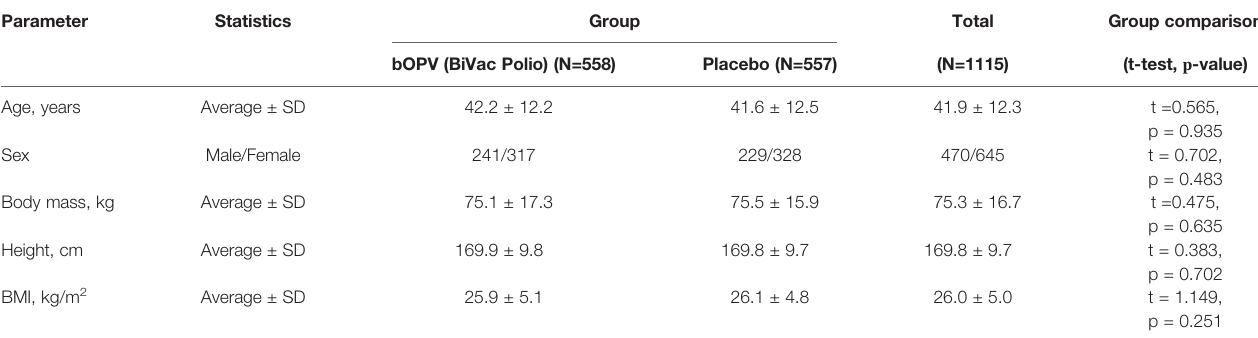
TABLE 1 | Average demographic and anthropometric characteristics of study